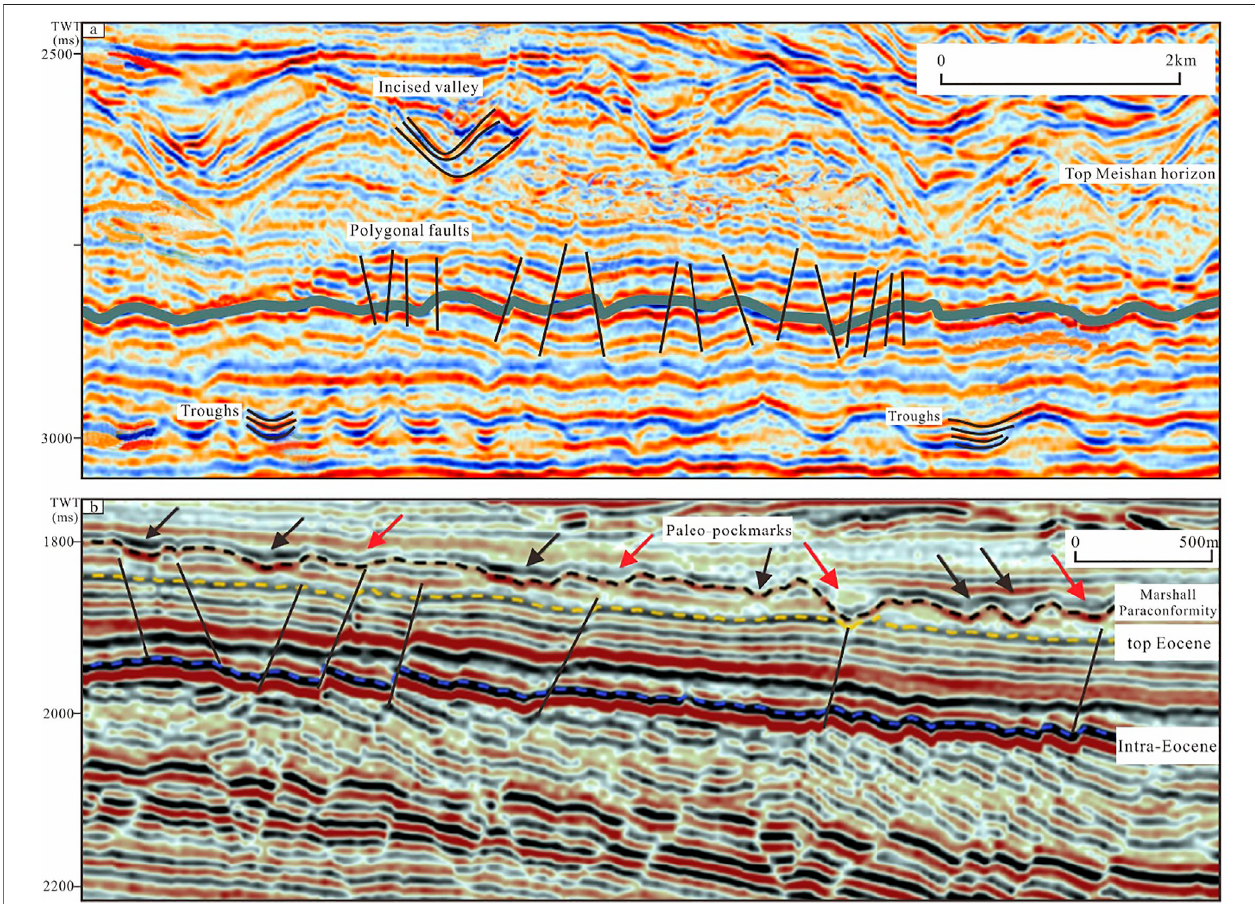
FIGURE 5 | (A) A representative seismic pro fi le shows troughs below polygonal faults and fl uidized sediments within incised valleys above polygonal faults in southeast direction in the Qiongdongnan Basin, South China Sea (modi fi ed from Sun et al. (2010)); (B) A seismic pro fi le through a polygonal fault system and buried pockmark fi eld in the Canterbury Basin, New Zealand (modi fi ed from Hoffmann et al. (2019)).